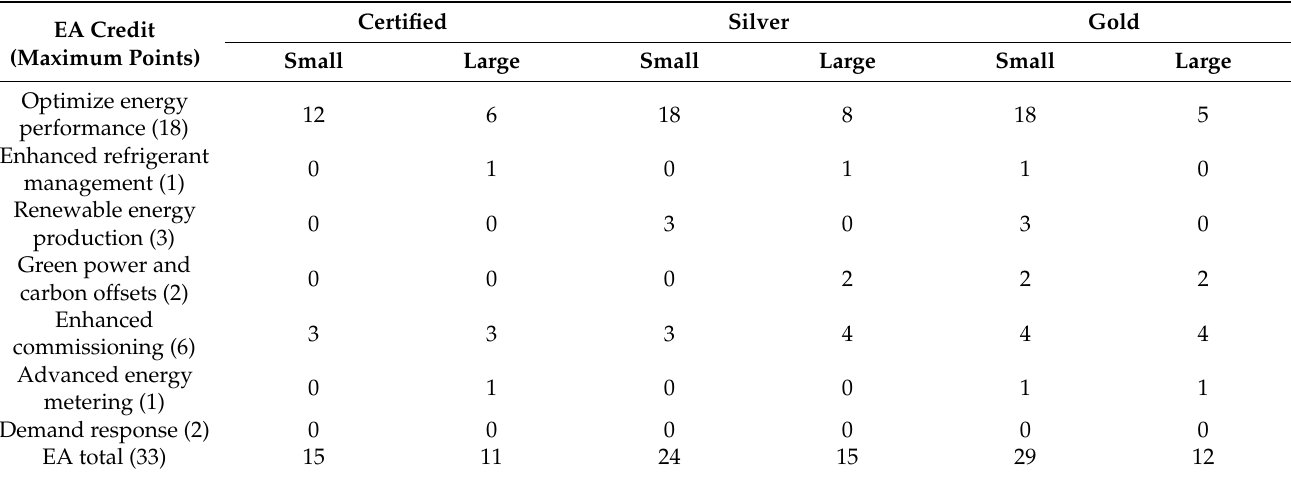
Table 7. The Energy and Atmosphere (EA) credits in three small and three large project sizes in LEED-NC v4